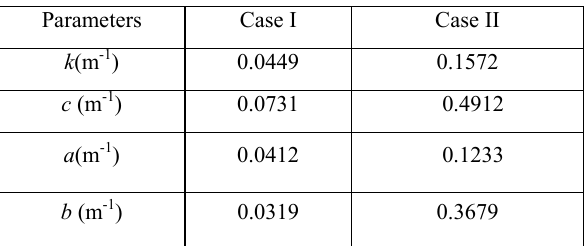
Table 2. Comparisons of two sites with